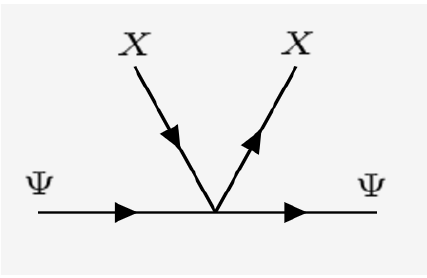
Figure 3 . Diagonal contribution to the soft masses of a given super(cid:12)eld (cid:9).